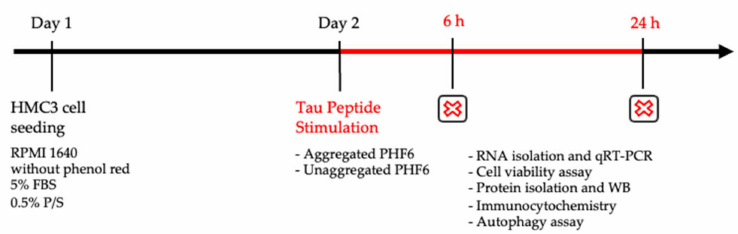
Figure 1. Experimental